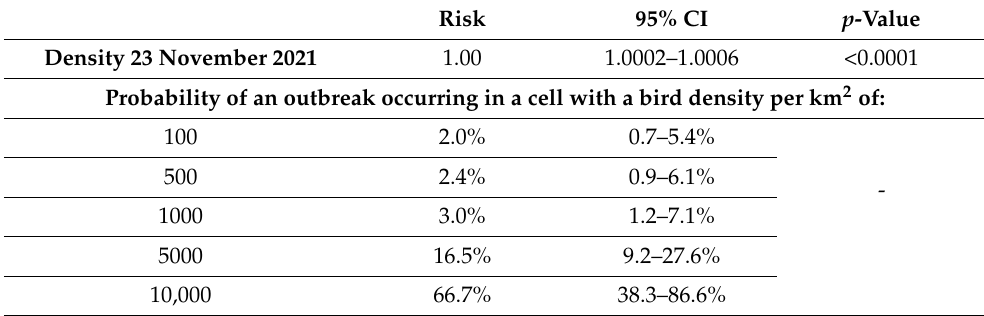
Table 5. Results of the statistical tests of the density classes of the birds per km 2 as of 23 November